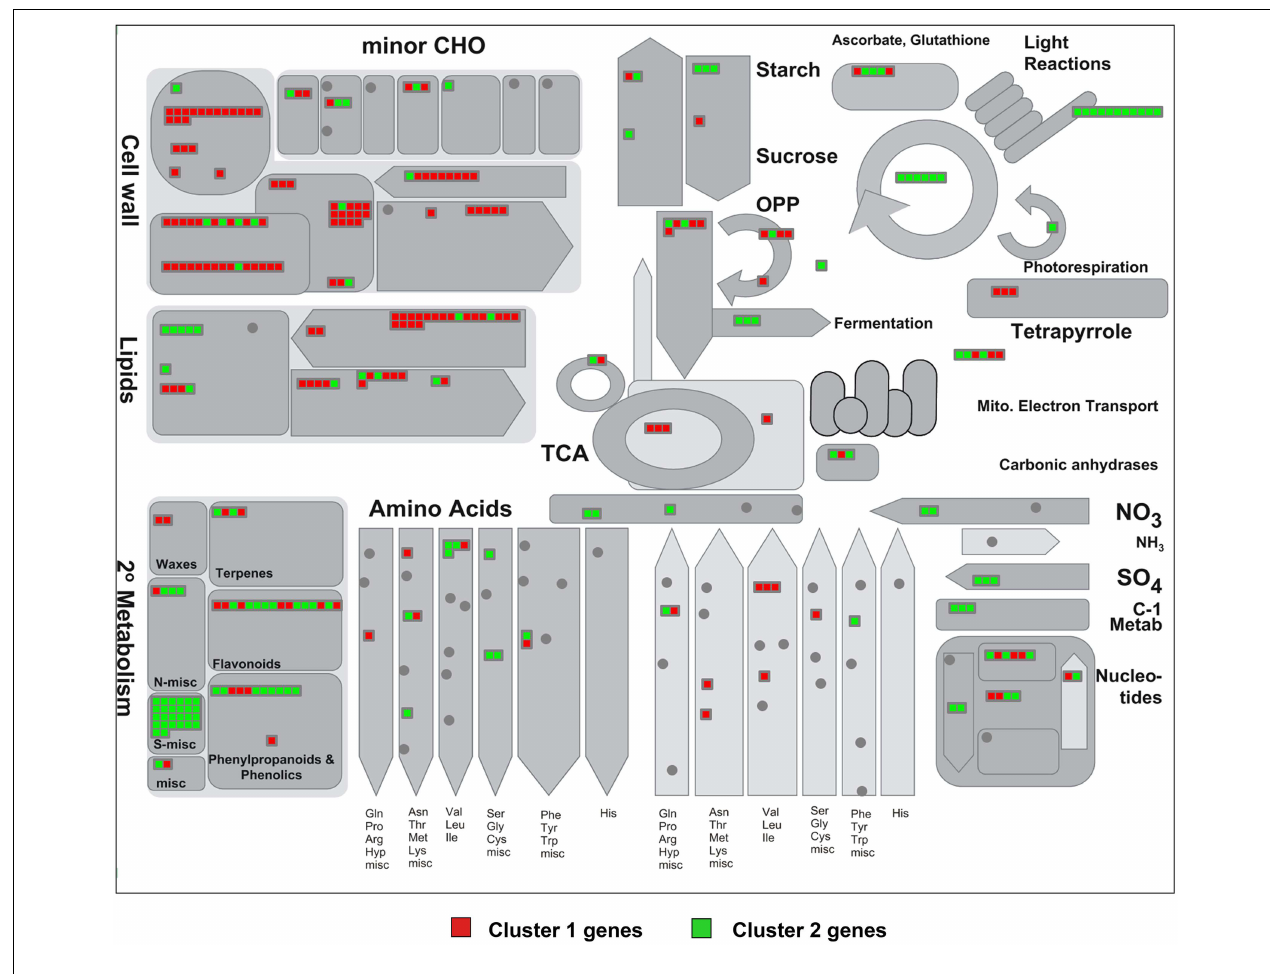
Each square represents a gene and displays a qualitative color code: red for genes up-regulated (cluster 1) and green for those down-regulated (cluster 2) in the mutants with respect to Col-0. Note the pathways with predominantly up-regulated (mostly red) and down-regulated (mostly green)